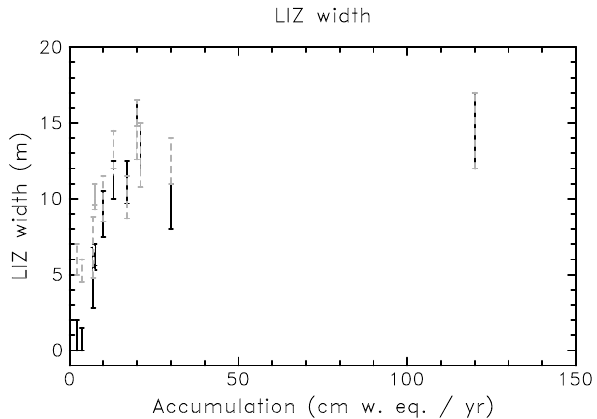
Fig. 9. Ranges of δ 15 N defined (in black) and reference gas defined (in grey) lock-in zone widths versus accumulation rate. The plotted ranges take into account the large uncertainty on the full close-off depth ( z F ). Uncertainties on z F were estimated using available in- formation about depths at which air could or could not be extracted from the firn and/or firn air sampling resolution.